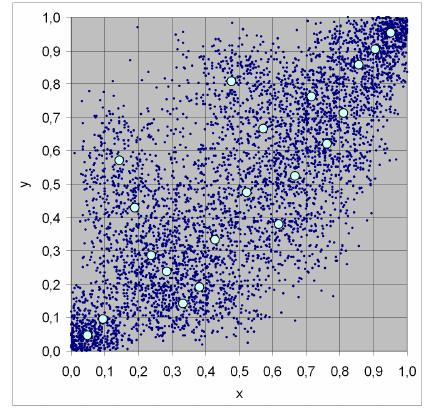
Figure 7: Bernstein copula